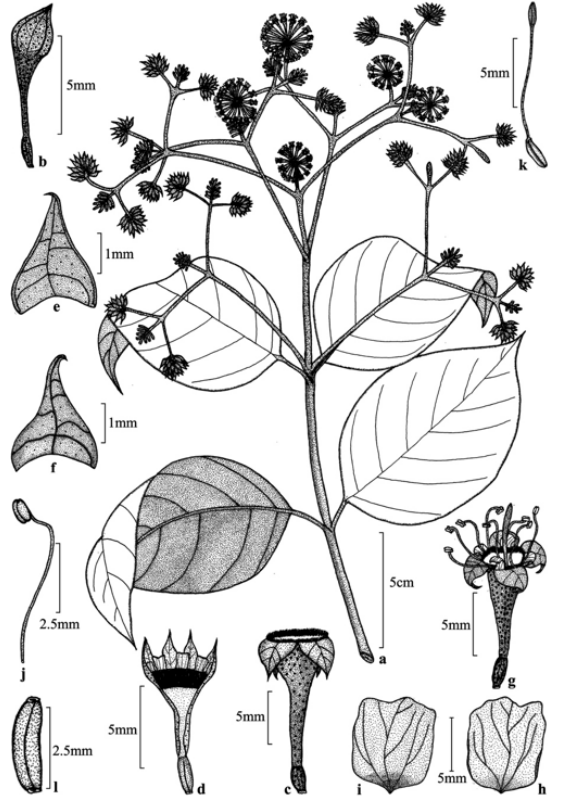
Figure 1. Combretum sundaicum Miq.: a—flowering twig | b— bud | c—calyx | d—calyx throat with rims of hairs | e—calyx lobe (adaxial view) | f—calyx lobe (abaxial view) | g—floret | h—petal (adaxial view) | i—petal (abaxial view) | j—androecium | k—gynoecium | l—